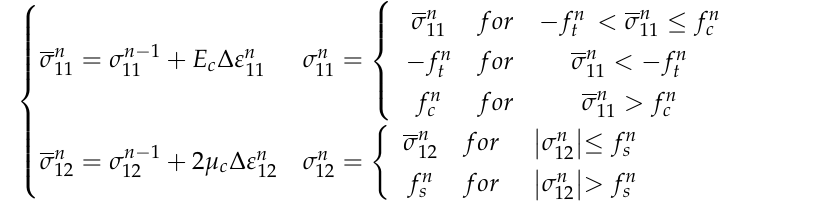
5 of 24 Figure 2. Concrete model.